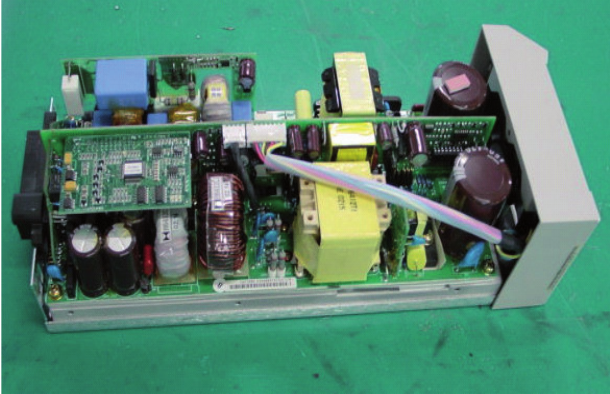
Fig. 2. Photo of actual AC/DC converter.